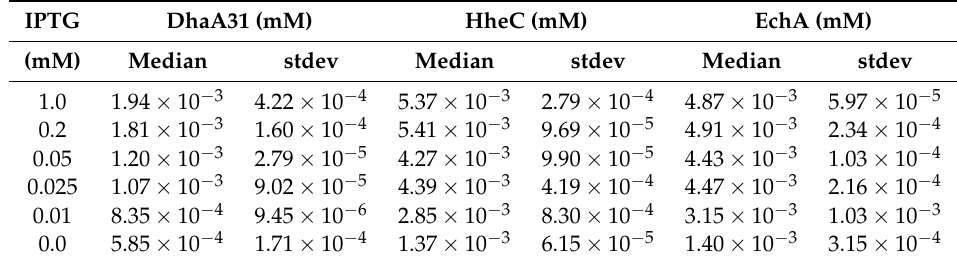
Table A6. Molar concentration of enzymes in cell-free extract calculated as a median of the values in Tables A3 and A4 with standard deviation values (i.e., stdev